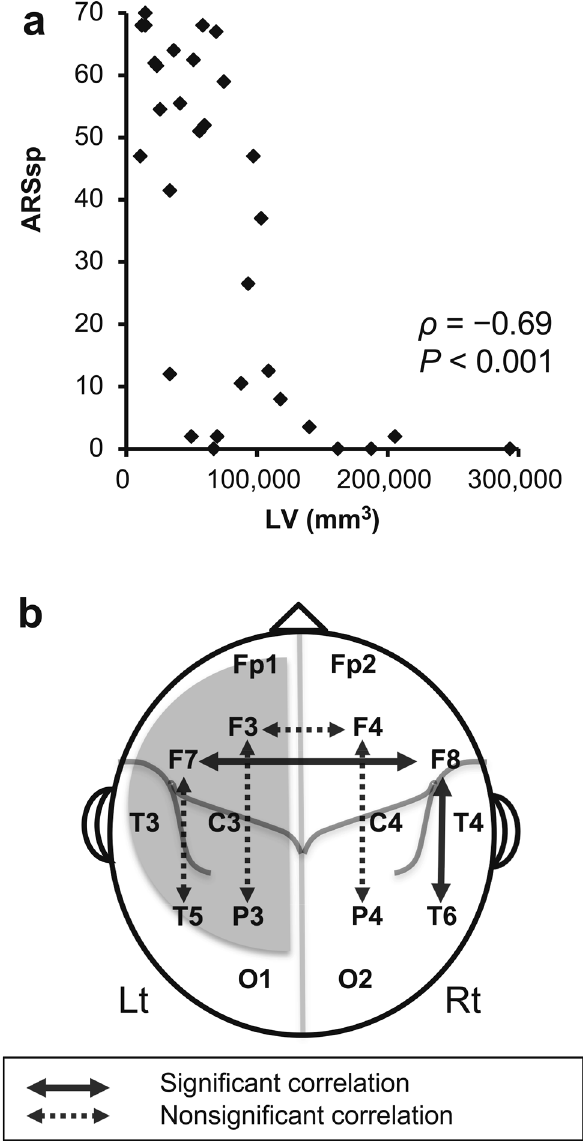
Figure 7. A correlation of LV with ARSsp scores and a summary of correlation analyses in this study. ( a ) A scatter plot showing a negative correlation between stroke LV and the ARSsp score. ( b ) A summary of the correlation analyses between six PSIs (F7F8-PSI, F3F4-PSI, F7T5-PSI, F3P3-PSI, F8T6-PSI, and F4P4-PSI)/the F8T6-PLI and ARSsp scores is plotted on the brain overlay. The solid arrow indicates a significant correlation, whereas dashed arrows indicate nonsignificant correlations. The gray shadow indicates the stroke lesion. ARSsp Aphasia Rating Scale speech, LV lesion volume, PSI phase synchrony index, PLI phase lag